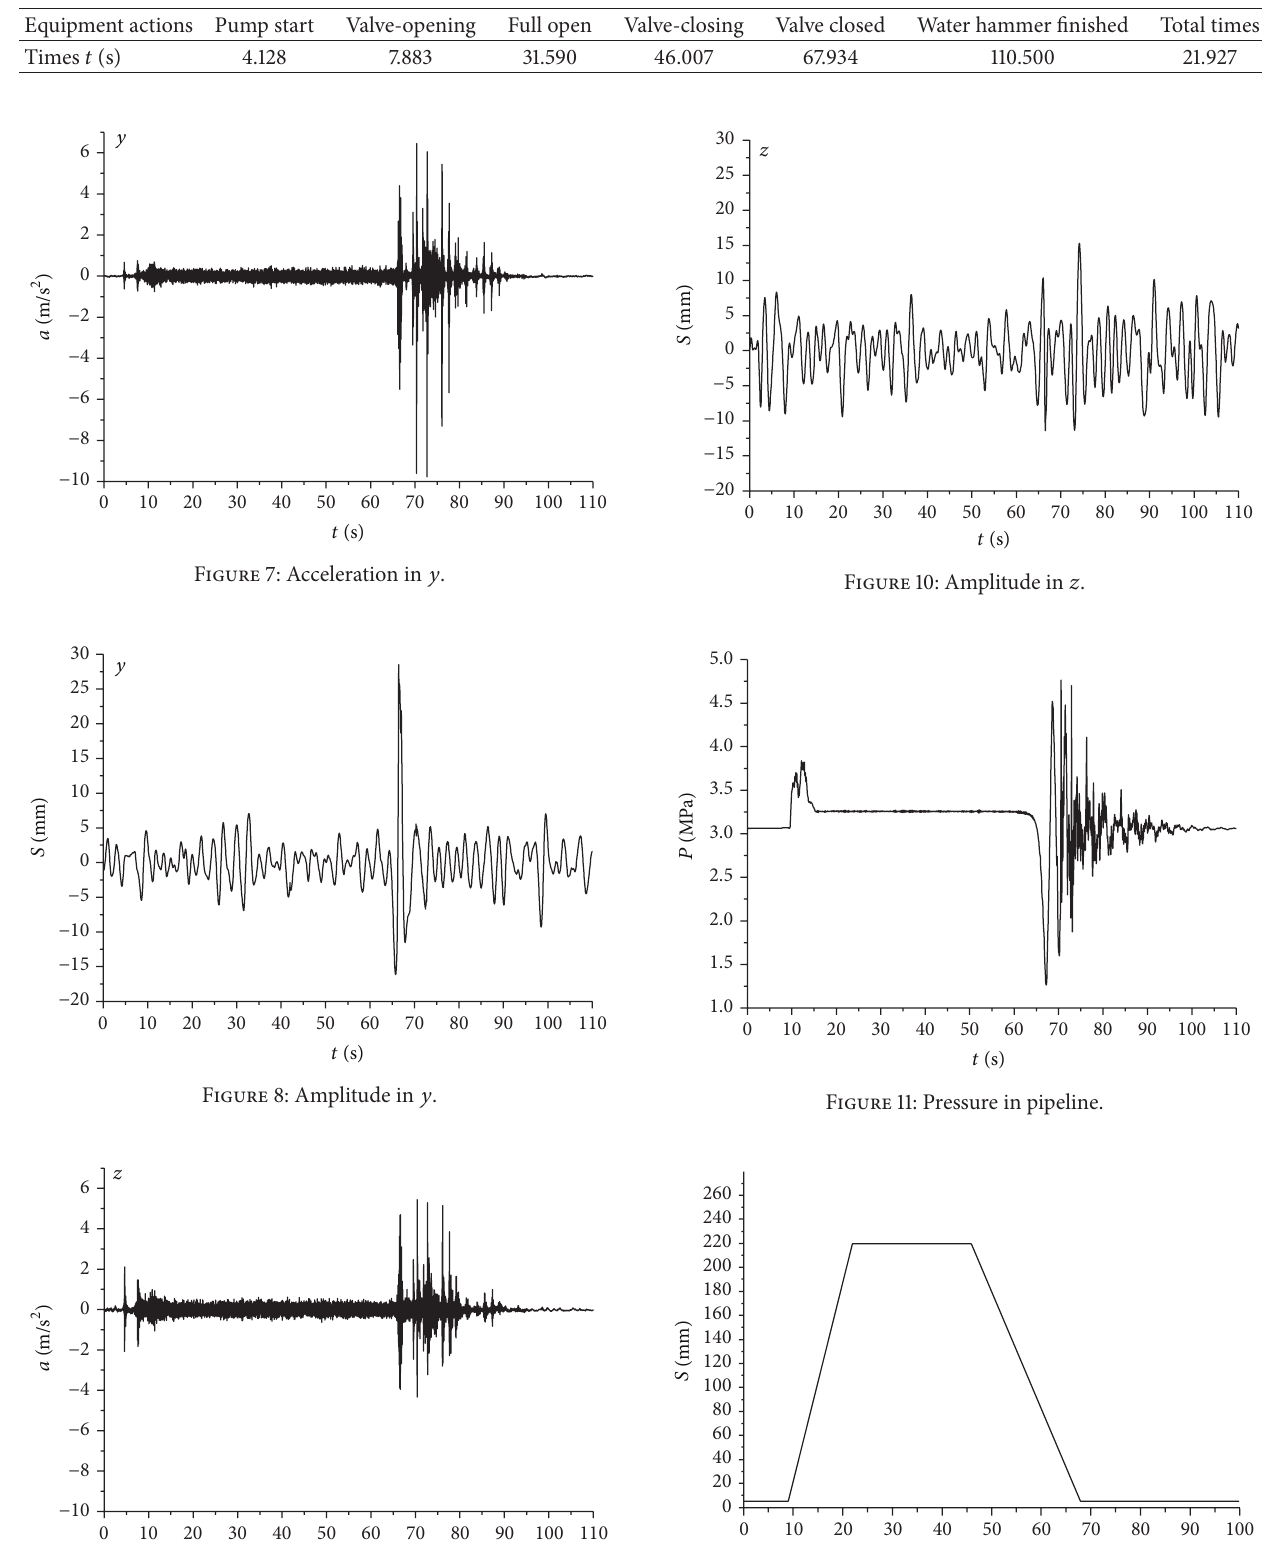
Figure 12: Amplitude of